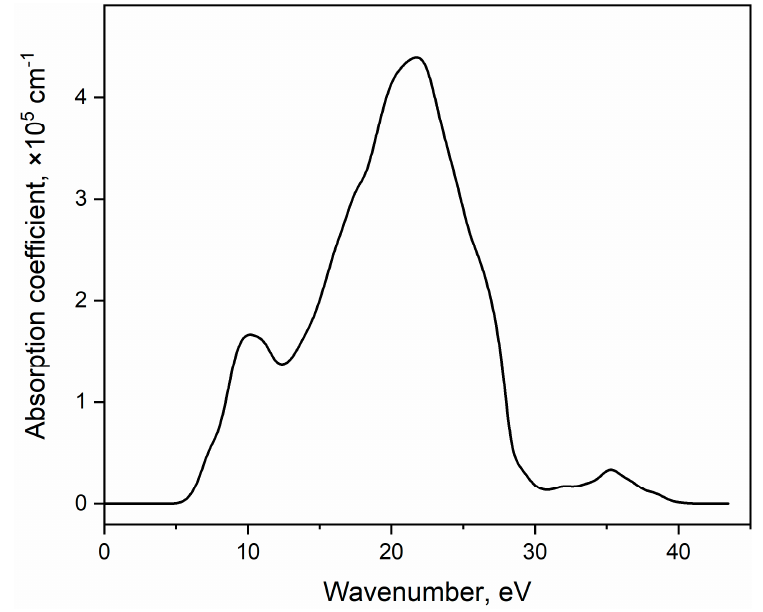
Figure 5. The calculated YAl 3 (BO 3 ) 4 absorption coefficient versus photon energy.